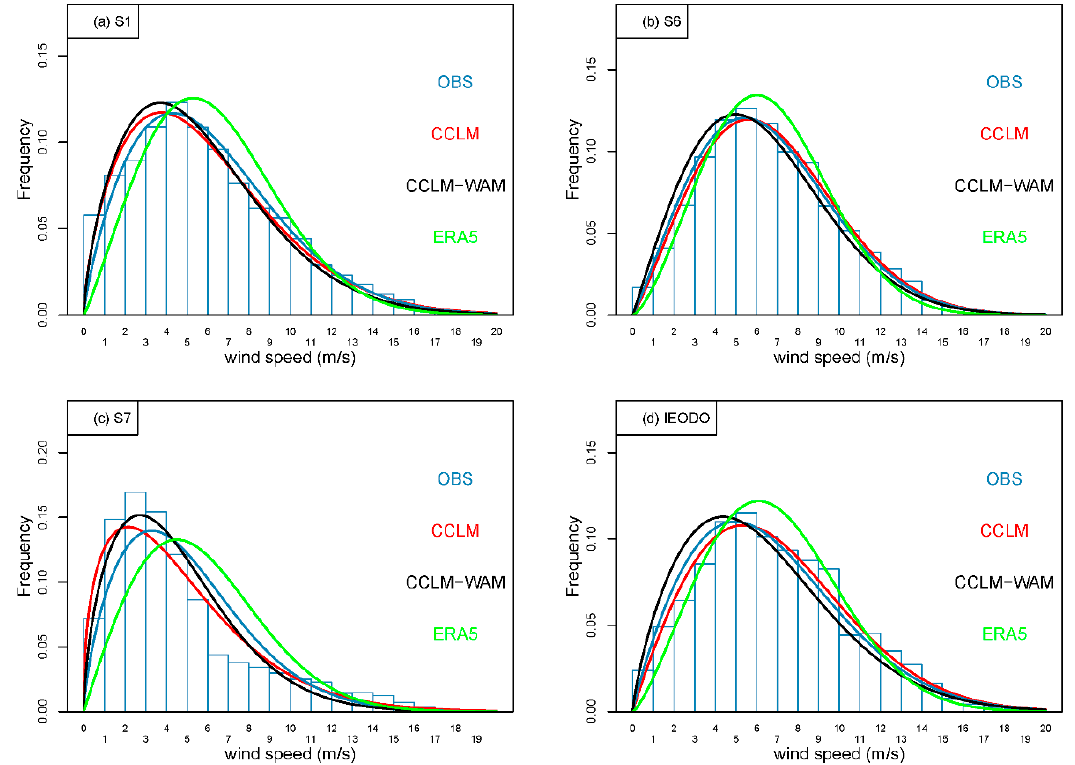
Figure 3. Observed wind histograms and fitted Weibull distributions for observed and simulated wind speeds at four stations in 2010.